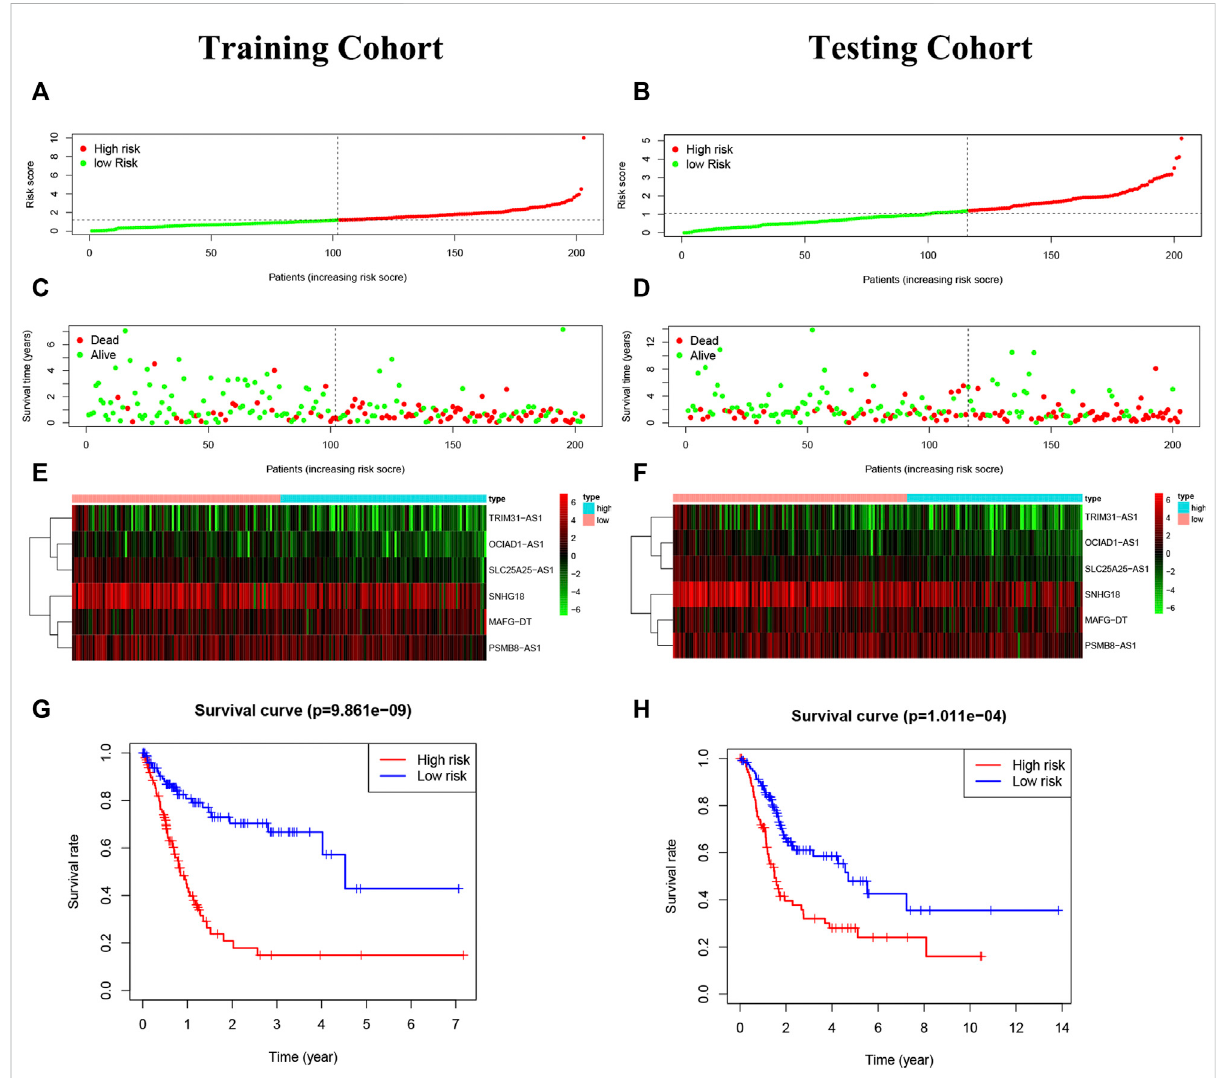
FIGURE 5 Constructionoftheriskmodel. (A,B) :Theriskscoreinthetraining cohortandvalidationcohort. (C,D) :ThesurvivalstatusofBCpatients. Green: survival, the red: death. The higher the risk score, the more intensive of death status. (E,F) : The heatmap of 6 pyroptosis-related lncRNAs. (G,H) : The Kaplan-Meier analysis in the two risk groups, and high-risk patients had worse overall survival than low-risk